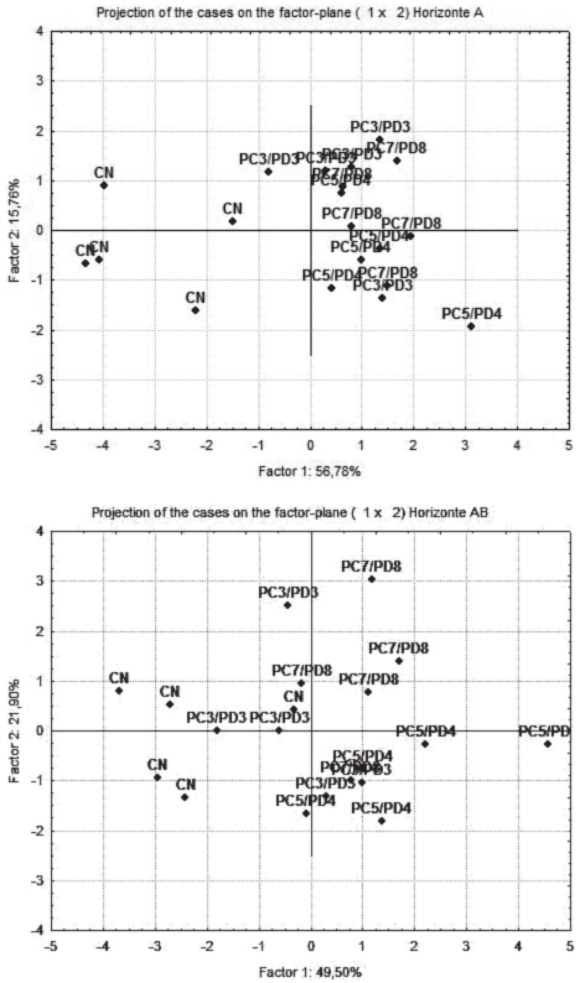
Figura 3. Gráfico da distribuição da nuvem de pontos dos horizontes A e AB. CN: Cerrado nativo; PD8: plantio direto há oito anos (PC7/PD8); PD4: plantio direto há quatro anos (PC5/PD4); e PD3: plantio direto há três anos